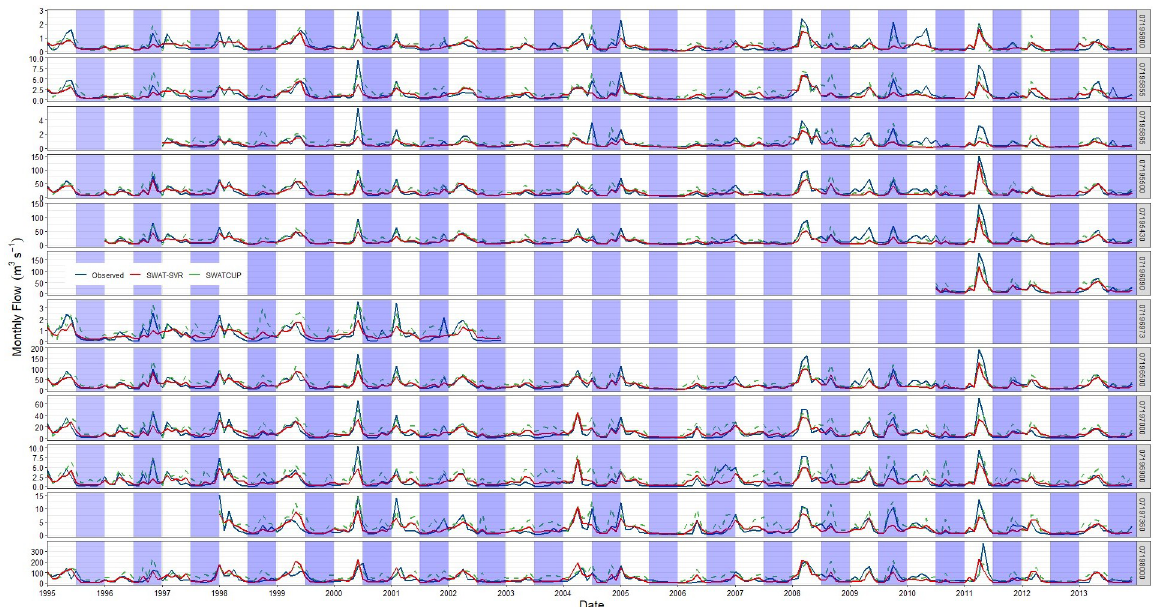
Fig 10. Monthly streamflow time series from observation and validated simulation by SWAT-SVM and SWAT-CUP. (The blue shade part represents the dry season from July to December).